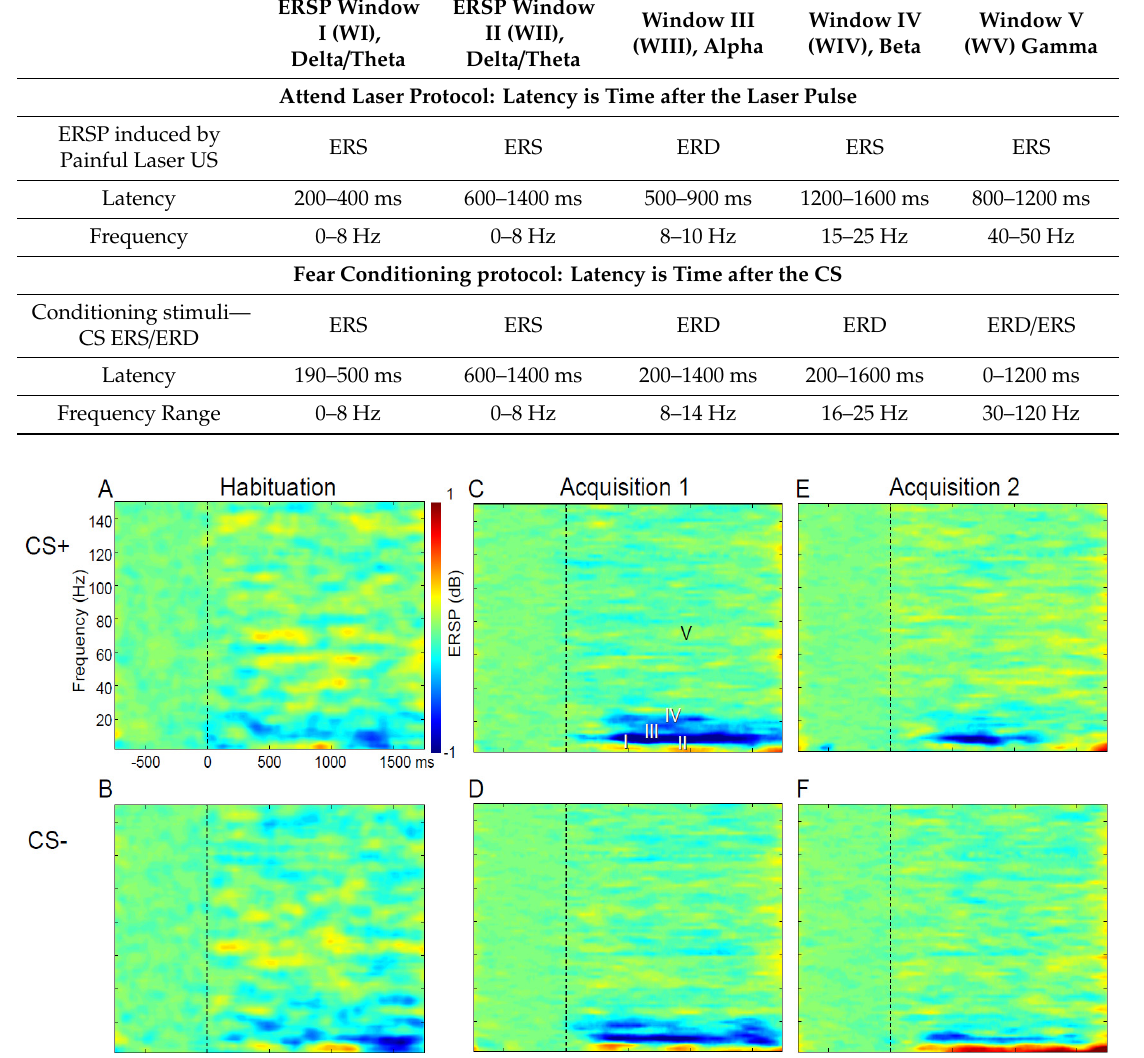
Figure 4. Time Frequency plots of ERSP in ( D , B ) across Channels and subjects. CS − and CS + are shown in the lower and upper rows, respectively. The three columns denote the stage of fear conditioning as labelled. The Habituation stage corresponds to Visual stage in Figure 1 and there are two sequential intervals for the Acquisition stage, i.e., as labelled Acquisition 1 ( C , D ) and Acquisition 2 ( E , F ) (Figure 1 Legend). Units for the axes of the time frequency plot are shown in ( A ) where time is shown relative to the CS at 0. Windows from I to V are presented in Table 1 (lower 3 rows) and illustrated in ( C ). Within these plots, hot and cold colors show significant increases and decreases in ERSP from that expected at random (green). Adapted from [12] .